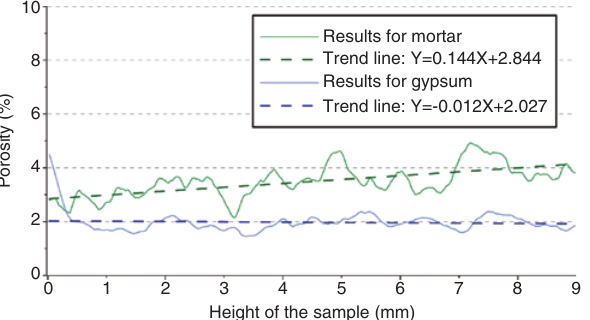
Figure 8: Porosity versus height of the sample.